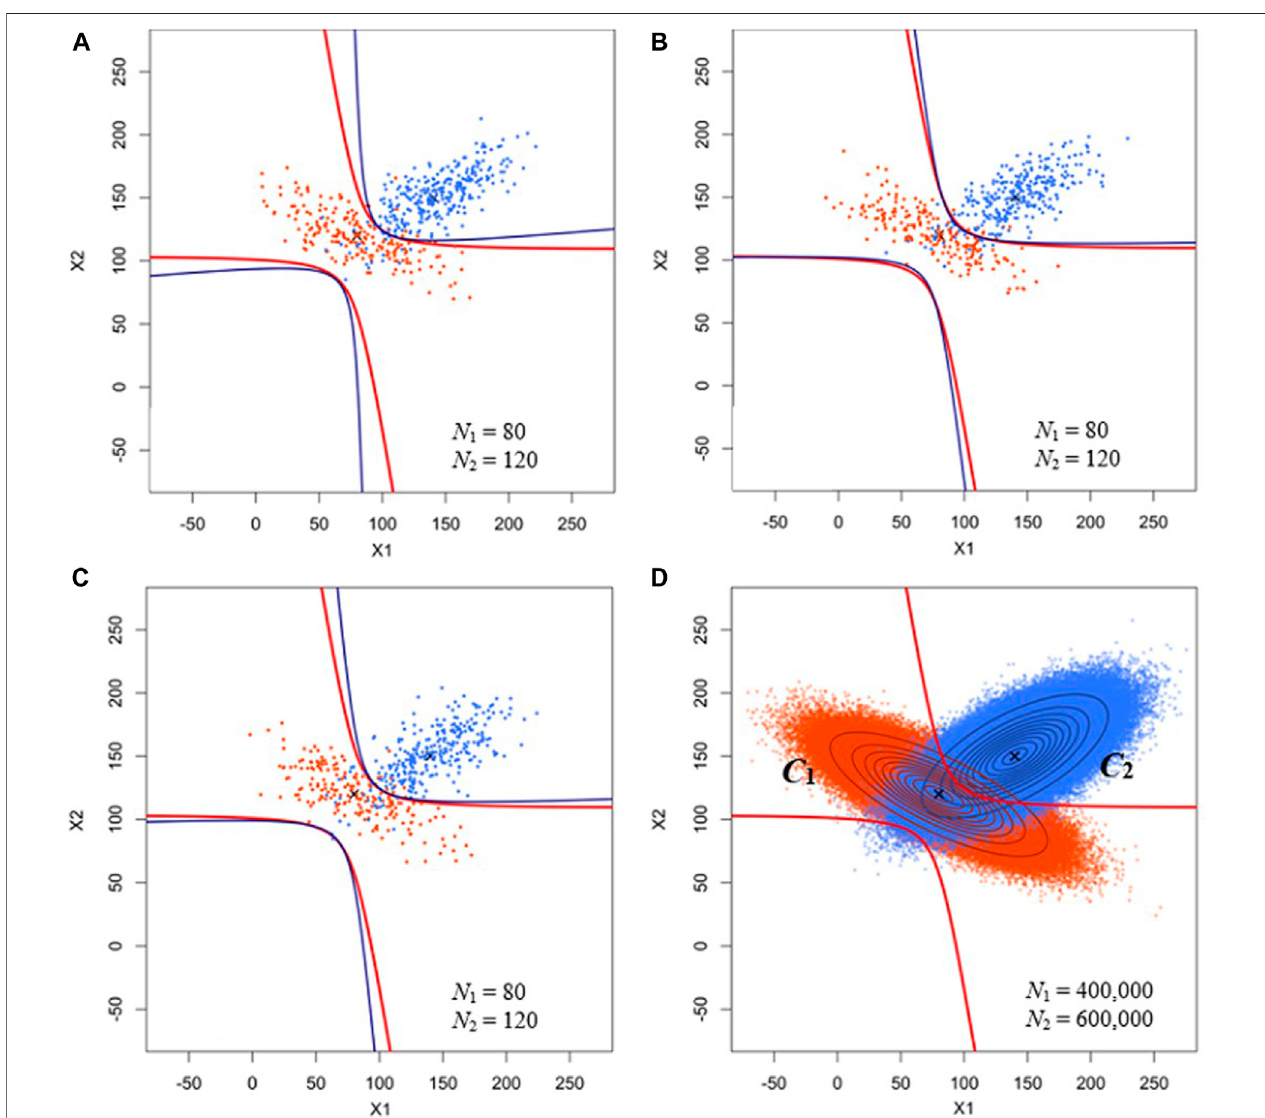
FIGURE 4 | (A – C) Training samples and training sample – dependent decision boundaries. (D) Theoretical decision boundary and isoprobability contours of the bivariate Gaussian distribution of C 1 and C 2 . Blue and red parabolic curves represent the training sample – dependent and theoretical decision boundaries, respectively. N 1 : number of training data points of C 1 ; N 2 : number of training data points of C 2.